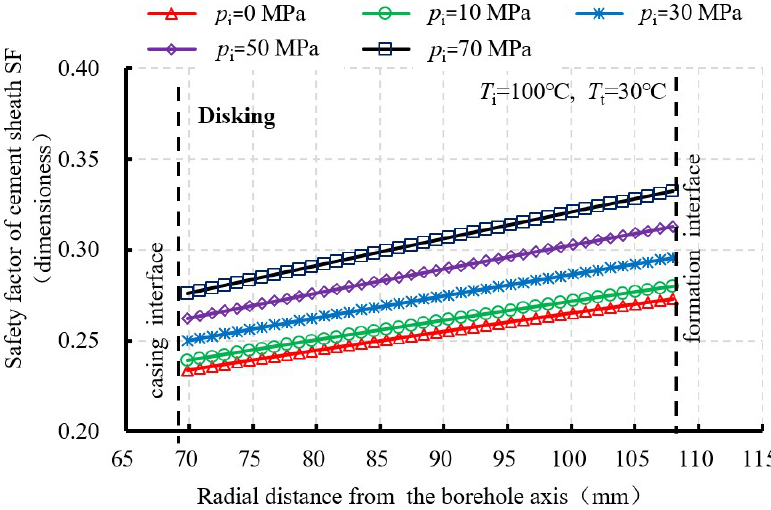
Figure 10. Radial distribution of the cement sheath safety factors for disking under different increased casing pressures p i and a decreased temperature of 70 °C at the casing inner wall.